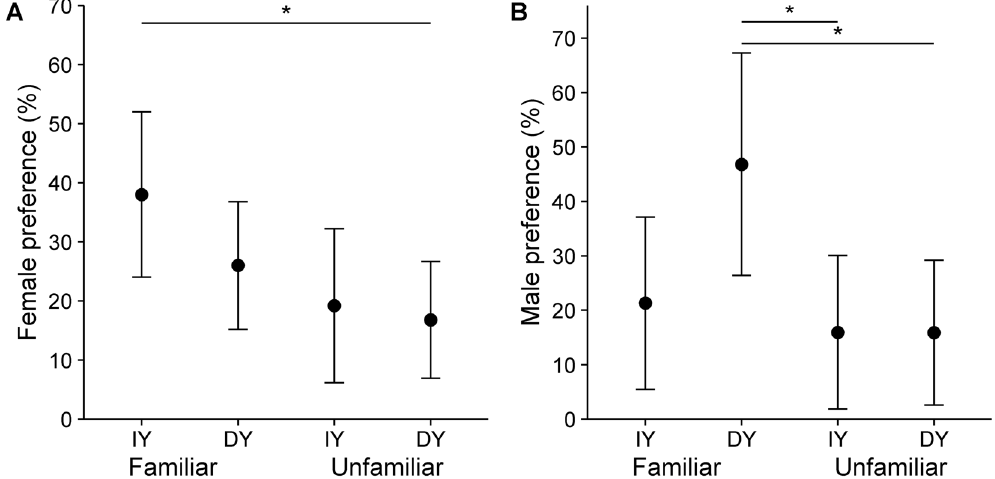
Figure 2. Results of social choice experiments on white-eyed bulbuls ( Pycnonotus xanthopygos ) using four stimuli with increased or decreased yellow ventral plumage colour (IY: Increased yellow, ID: Decreased yellow) and familiarity. Means presented as dots with 95% CL. Significant differences are marked with an asterisk (Tukey’s post hoc test). ( A ) female social choice ( B ) male social